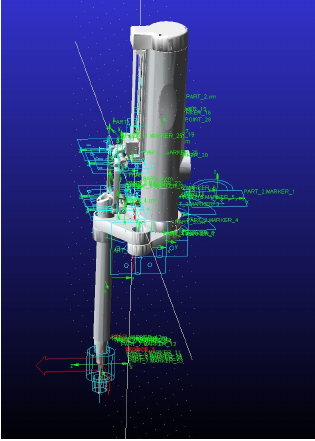
Figure 10. 3D model in ADAMS.